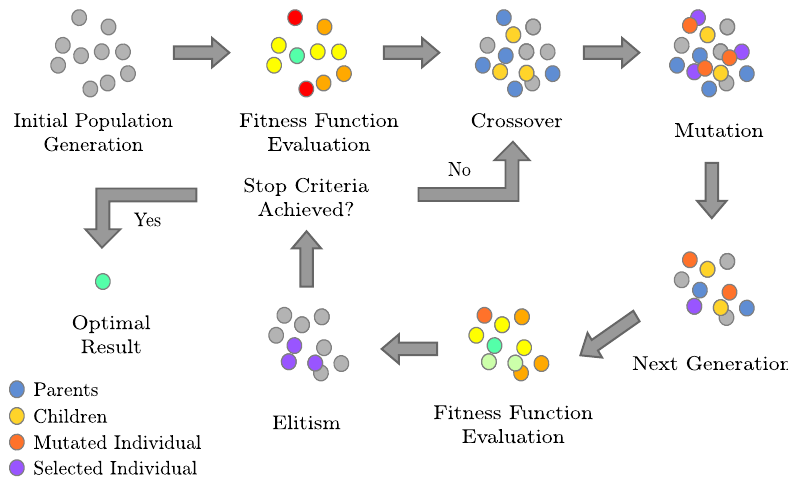
Figure 3. Illustrative procedure of Genetic